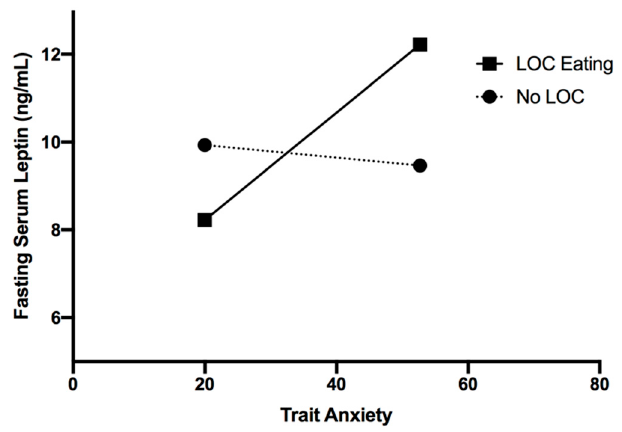
Figure 1. Interaction of LOC eating and trait anxiety in relation to fasting serum leptin ( p = 0.02).